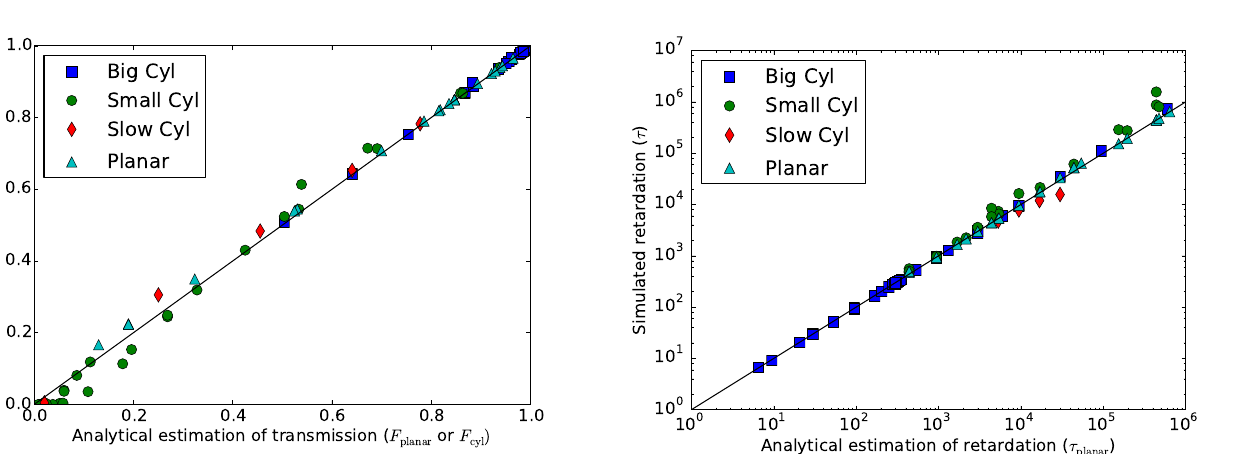
Figure 3. Simulated retardation as a function of theoretical retarda- tion. In general, there is excellent agreement between the analytical solution and numerical simulations. Legend categories are the same as Fig. 2, and the graph includes a 1 : 1